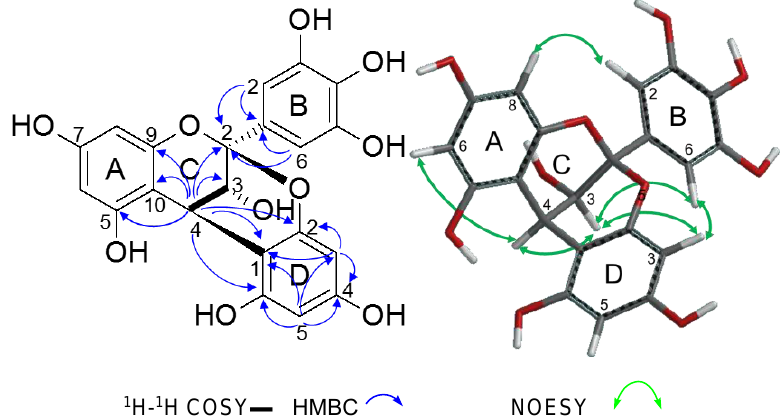
Figure 13. 1 H- 1 H COSY, HMBC, and NOESY correlations of 16 .